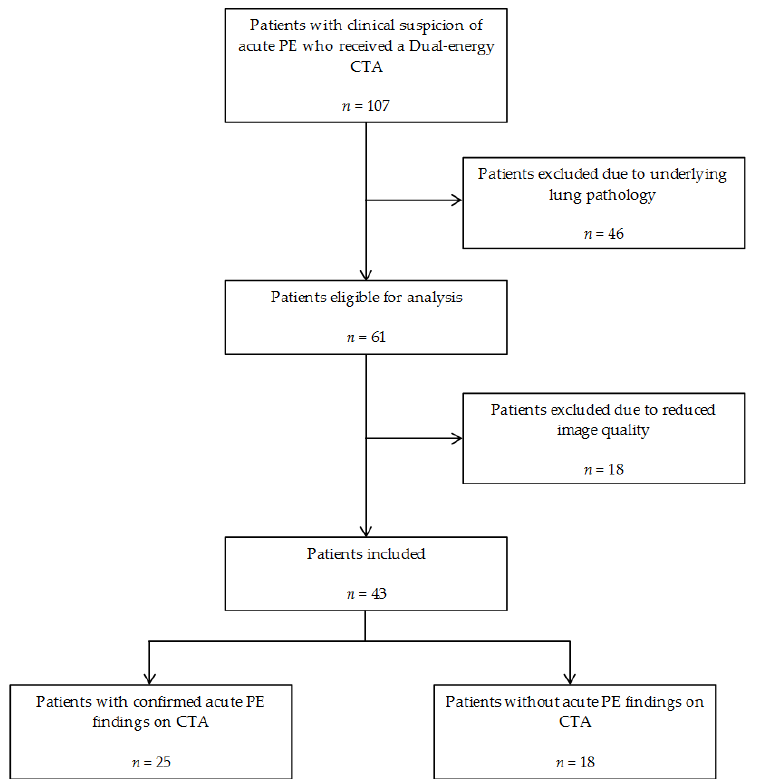
Figure 1. Flowchart of patient inclusion and exclusion. CTA = CT angiography, PE = Pulmonary embolism.